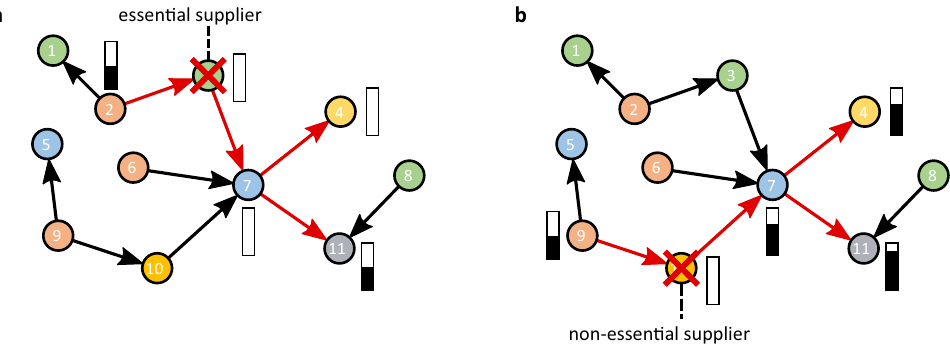
Figure 2. Schematic example of downstream and upstream shock propagation with generalized Leontief production functions. Red links propagated shocks; bars next to affected firms denote the resulting production level. Supplier replaceability and edge weights are omitted for simplicity. ( a ) Simulated production losses due to the failure of firm 3, h d 3 ( 1 ) = h u 3 ( 1 ) = 0 (red cross). Firm 3 is an essential supplier to firm 7, i.e. firm 7 can not produce without its supplies, h d 7 ( 2 ) = 0 , and forwards the shock further downstream to firms 4, h d 4 ( 3 ) = 0 ,